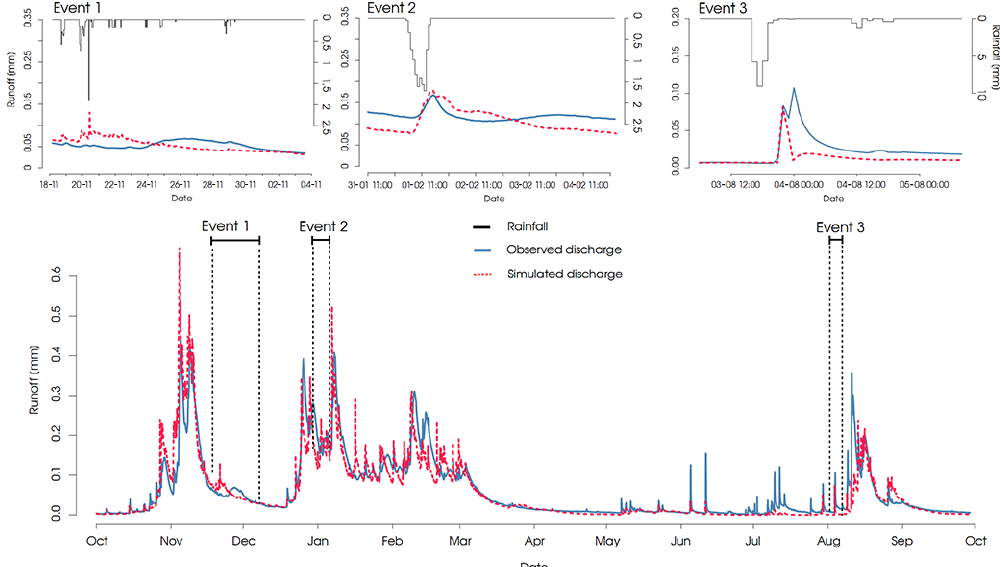
Figure 9. Observed and simulated runoff of the Colpach catchment. Moreover, three rainfall–runoff events are highlighted and displayed separately.